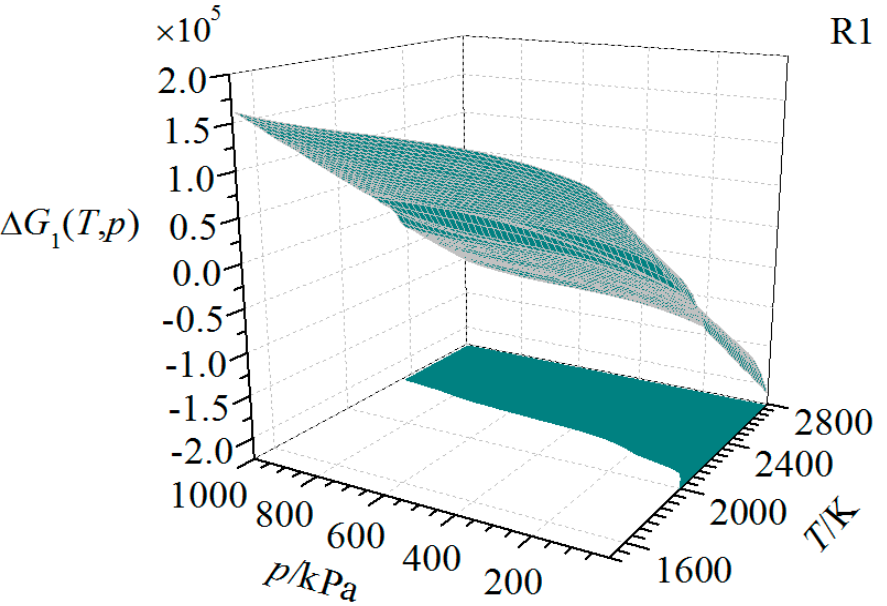
Figure 6. Gibbs energy dependence on temperature and CO partial pressure for reaction R1.